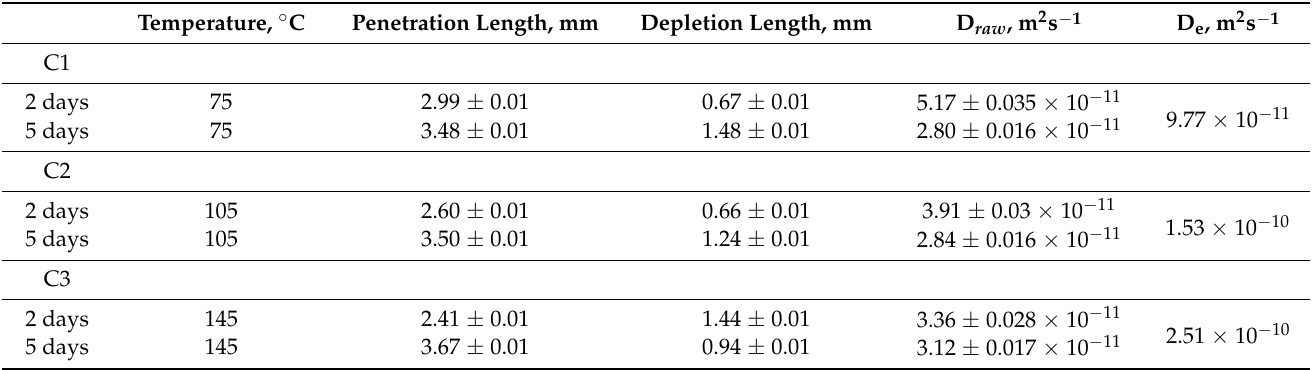
Table 6. Diffusion coefficients obtained from